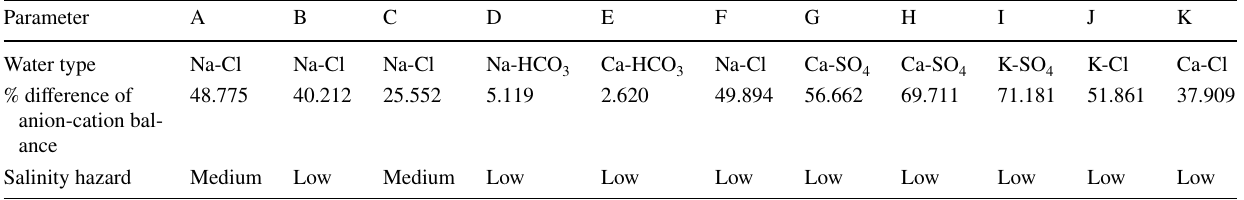
Fig. 7 Piper diagram for Ajali River water